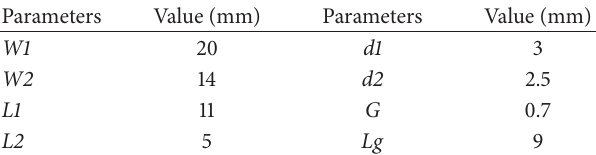
Table 1: Parameters of the two-step beveled monopole